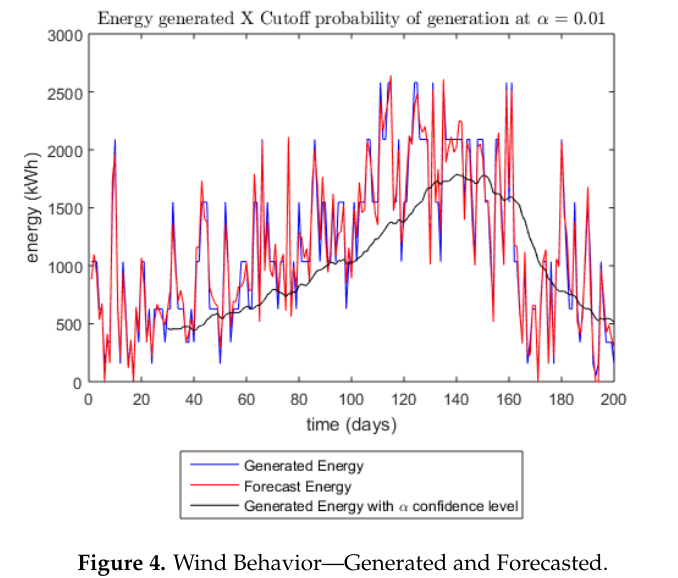
Figure 4. Wind Behavior—Generated and Forecasted.